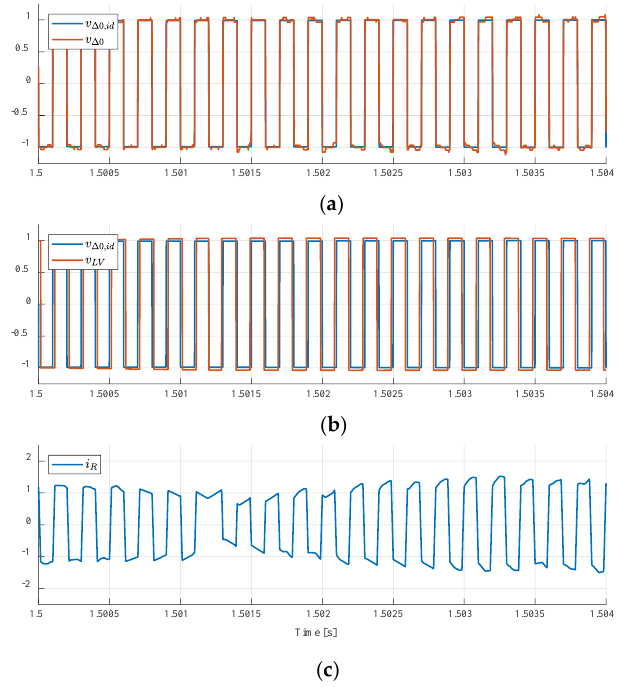
Figure 9. Behavior in correspondence of 100 kW to − 100 kW step variation of the actual MMC differential homopolar output compared with its mean value ( a ) of the transformer voltages ( b ) and of the transformer current ( c ).